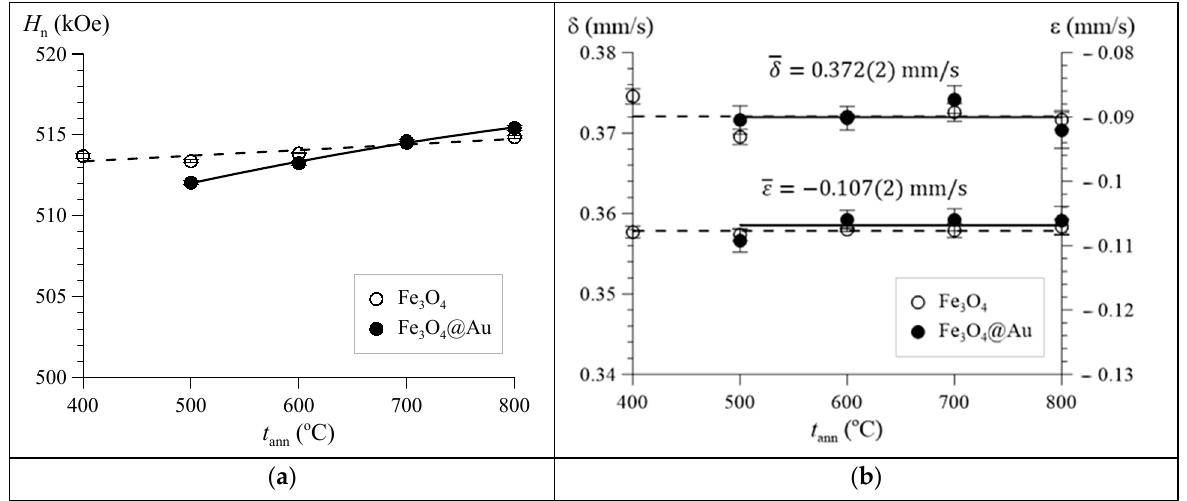
Figure 15. Dependences on the annealing temperature t ann of the hyperfine magnetic field H n ( a ), the isomer shift δ , and the quadrupole shift ɛ ( b ) for hematite α -Fe 2 O 3 in Fe 3 O 4 and Fe 3 O 4 @Au nanoparticles.